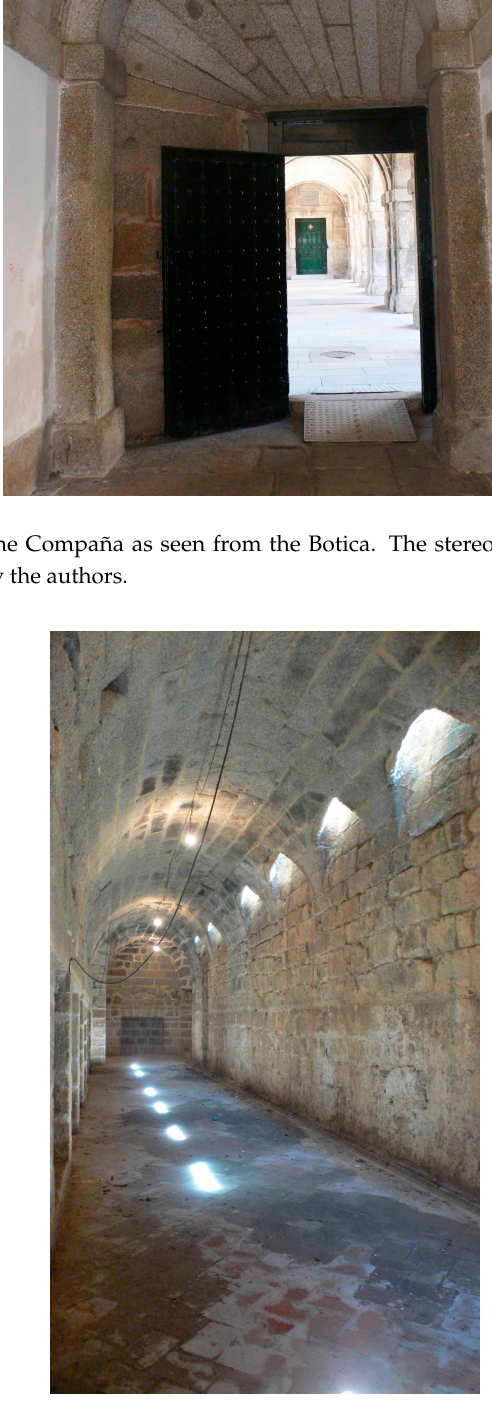
Figure 19. The lower cellar of the Galería from the south. Photograph by the authors.